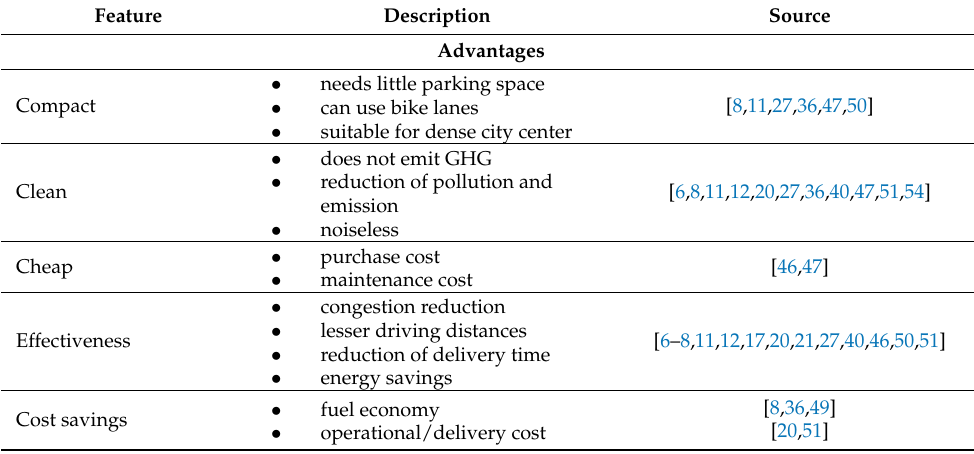
Table 1. Advantages and disadvantages of using bikes for cargo